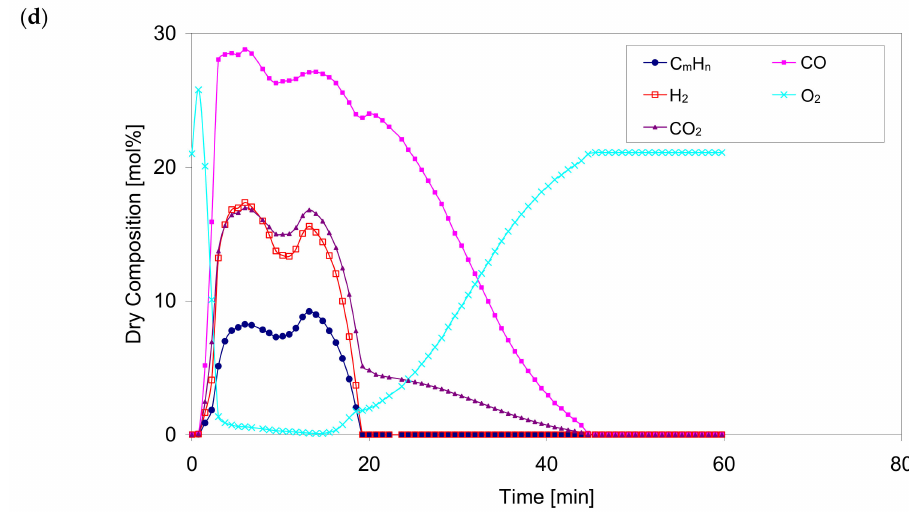
Figure 8. Results of numerical calculations of gasification of biomass in the form of wood pellets –influence of the oxidizer temperature on the process course for 20 kg pellets with a diameter of 12 mm, volumetric flow rate of the oxidant 50 Nm 3 /h: ( a ) 350 ◦ C; ( b ) 530 ◦ C; ( c ) 700 ◦ C; ( d ) 830 ◦ C.